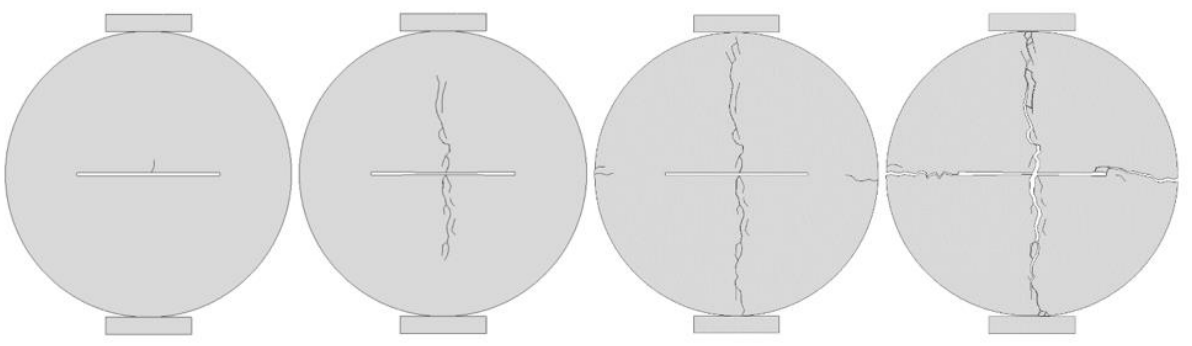
Figure 9. Fracture process for Brazilian disc with a crack of 90° angle.